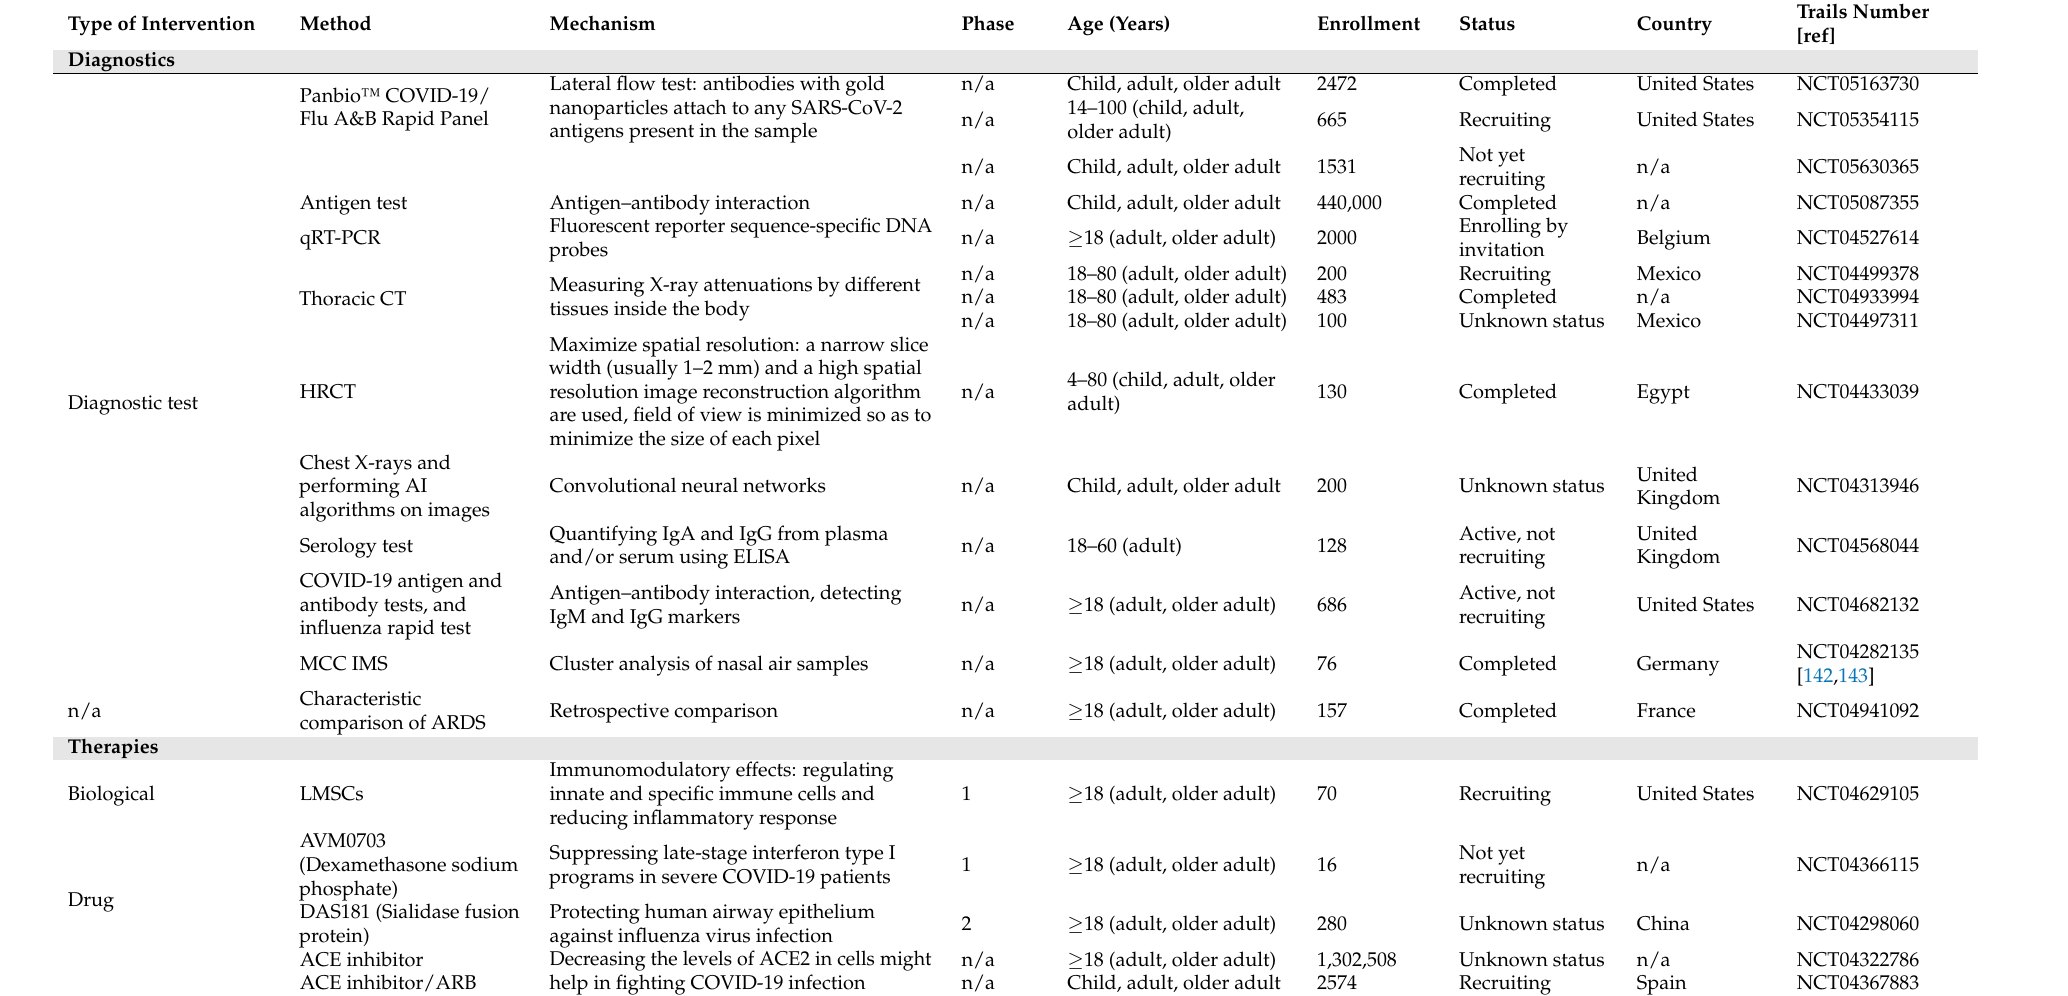
Table 2. Clinical trials on combined administration against COVID-19 and